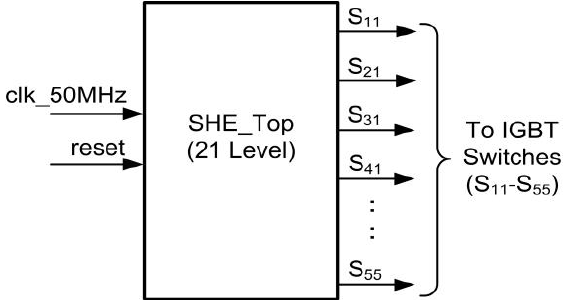
Figure 6. Top level of the SHE digital switching controller.